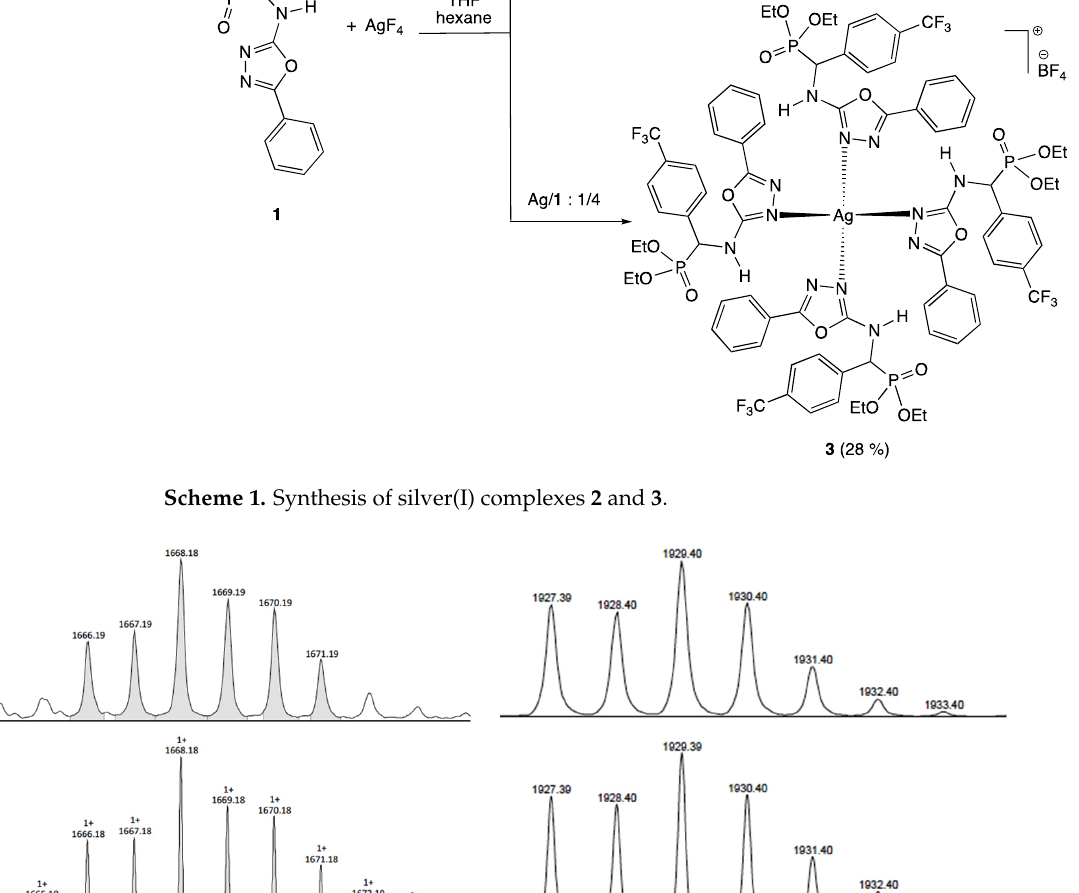
Scheme 1. Synthesis of silver(I) complexes 2 and 3 . 2.2. Single ‐ Crystal X ‐ ray Diffraction Studies The binuclear complex 2 crystallized in the monoclinic asymmetric space group P 2 1 /c and contained two silver atoms, two distinct enantiomeric α ‐ aminophosphonate 1 (the two C9 atoms have an ( R ) ‐ and an ( S ) ‐ configuration), and two BF 4 anions. The CF 3 (F1, F2, and F3) moiety was disordered over two positions with a ratio of 0.6/0.4 (Figure 3 and Table 1). The silver atoms, which adopted {AgN 2 F} planar trigonal geometries, were simultaneously bridged by two oxadiazole rings of two ligands with Ag1 ‐ N1 and Ag1 ‐ N2 bonds of 2.260(2) and 2.215(2) Å, respectively. The coordination spheres were completed with the coordination of the counter anion BF 4 through a fluorine atom [23] (Ag ‐ F4 2.652(2) Å; sum of van der Waals radii 3.27 Å [60]). The counter anion was also maintained by a hydrogen bond with the amine (NH3 ∙∙∙ F5 2.117 Å). The distance between the two silver ions was 3.417 Å. This distance was slightly smaller than the sum of the van der Waals radii of two silver ions (3.44 Å [60]), suggesting the occurrence of very weak argentophilic interactions [61]. The oxadiazole rings were planar with the phenyl